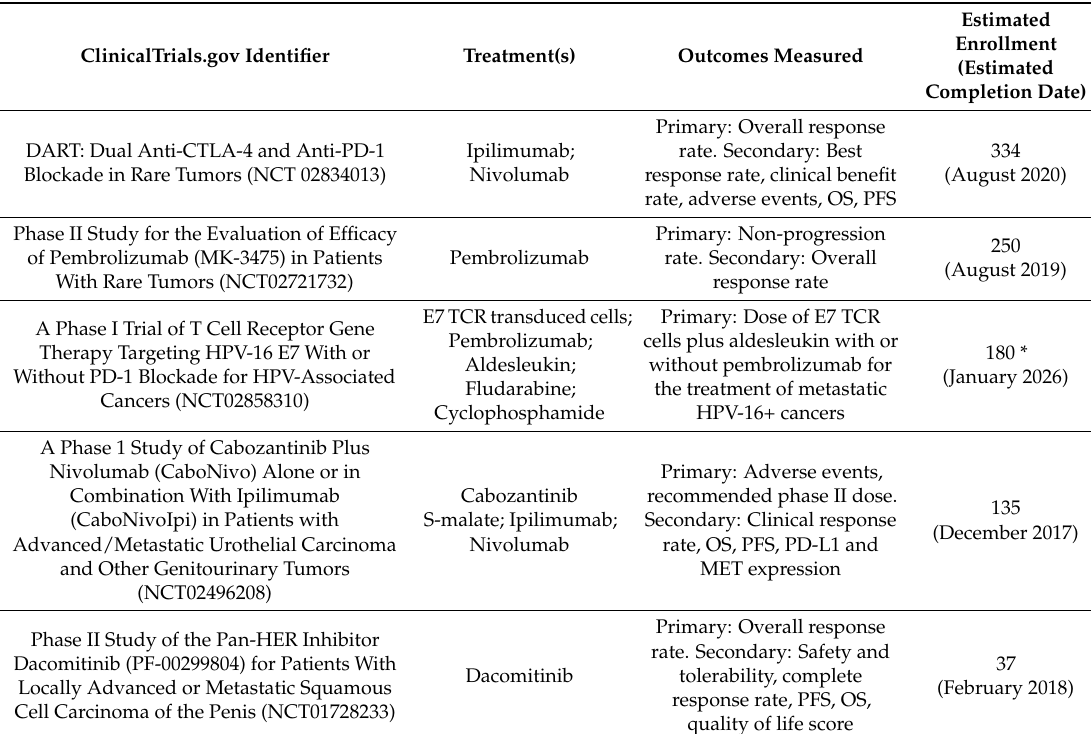
Table 1. Currently open trials of systemic targets in penile